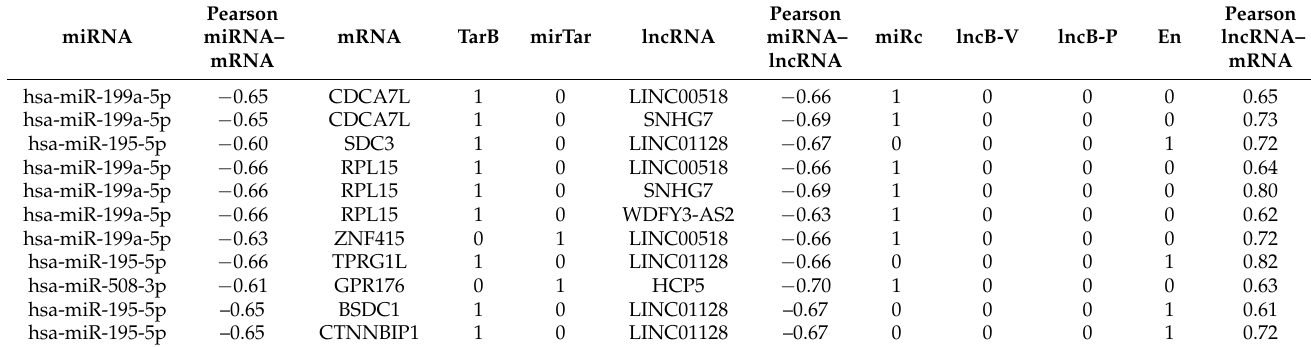
Table 1. LncRNA–miRNA–mRNA axes featuring physical interactions calculated by using the most stringent threshold (correlation coefficient >